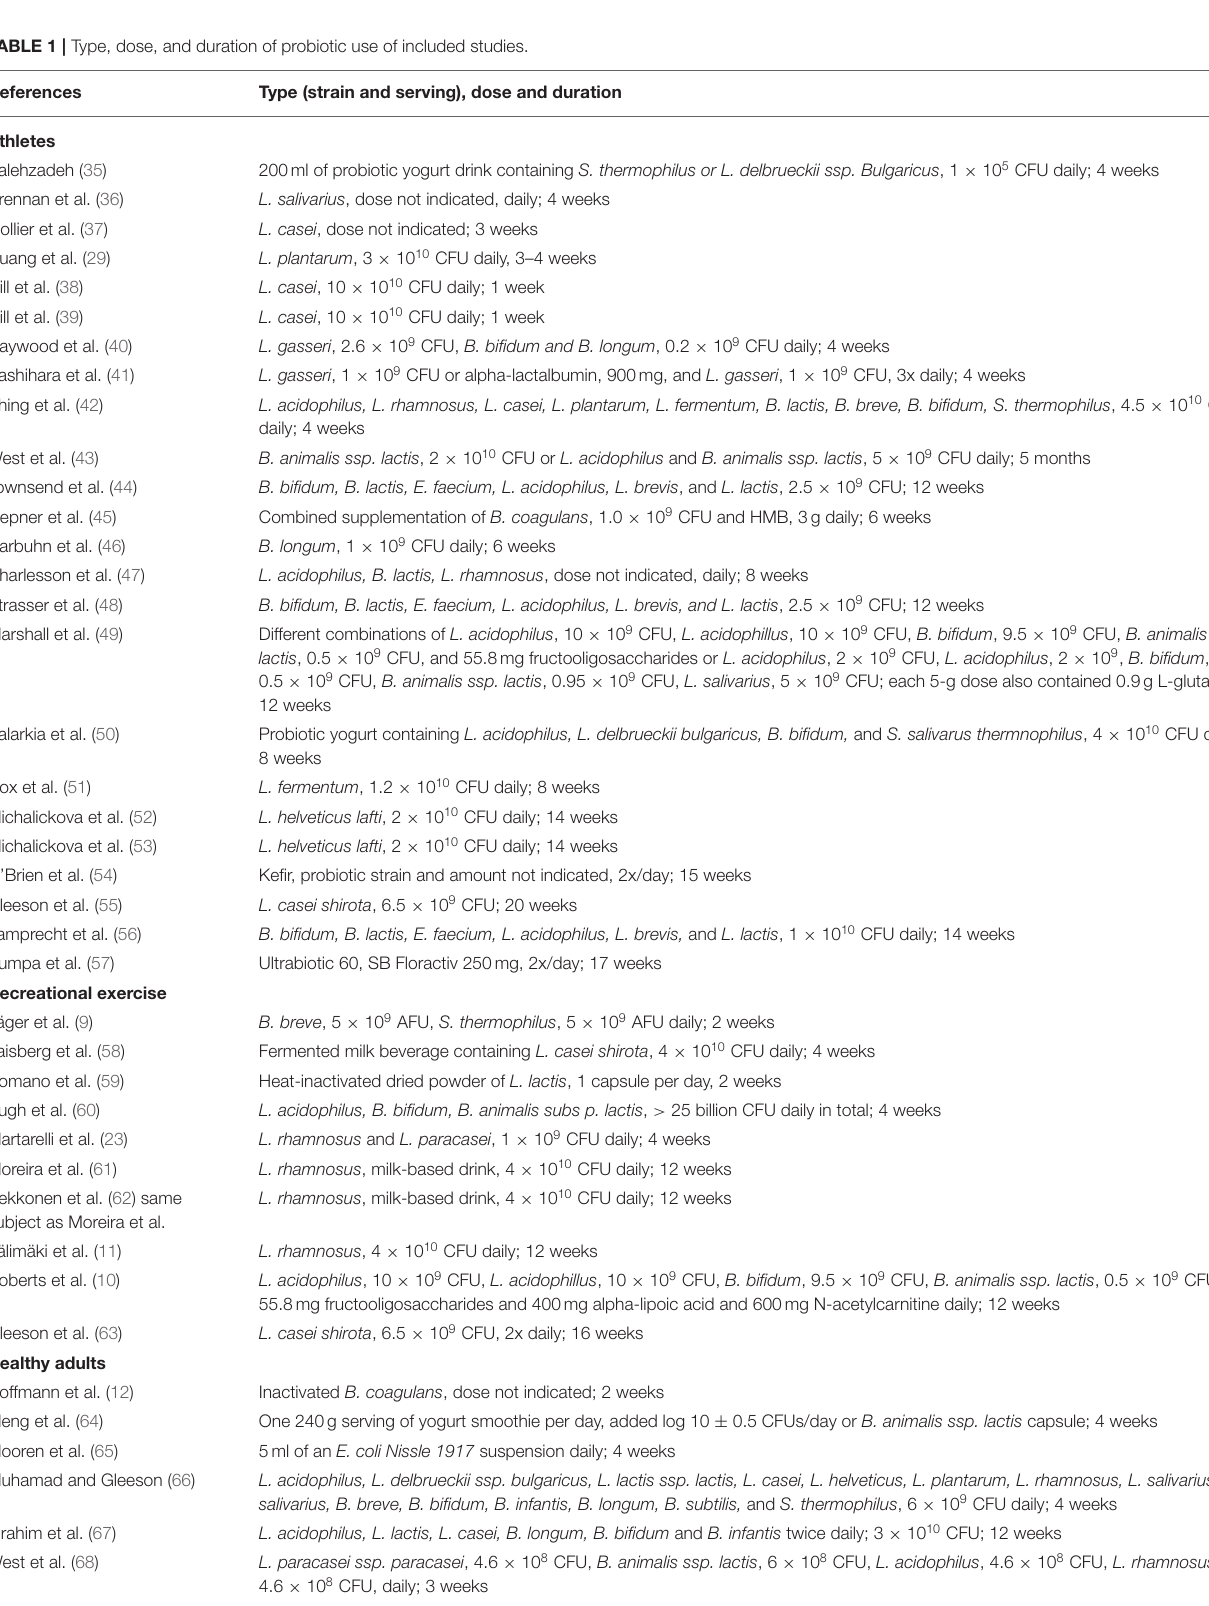
TABLE 1 | Type, dose, and duration of probiotic use of included